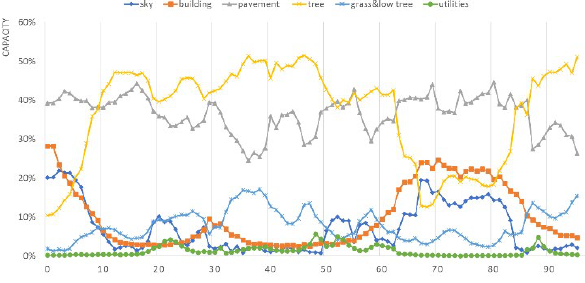
Figure 12 . Changes in landscape components (Panorama